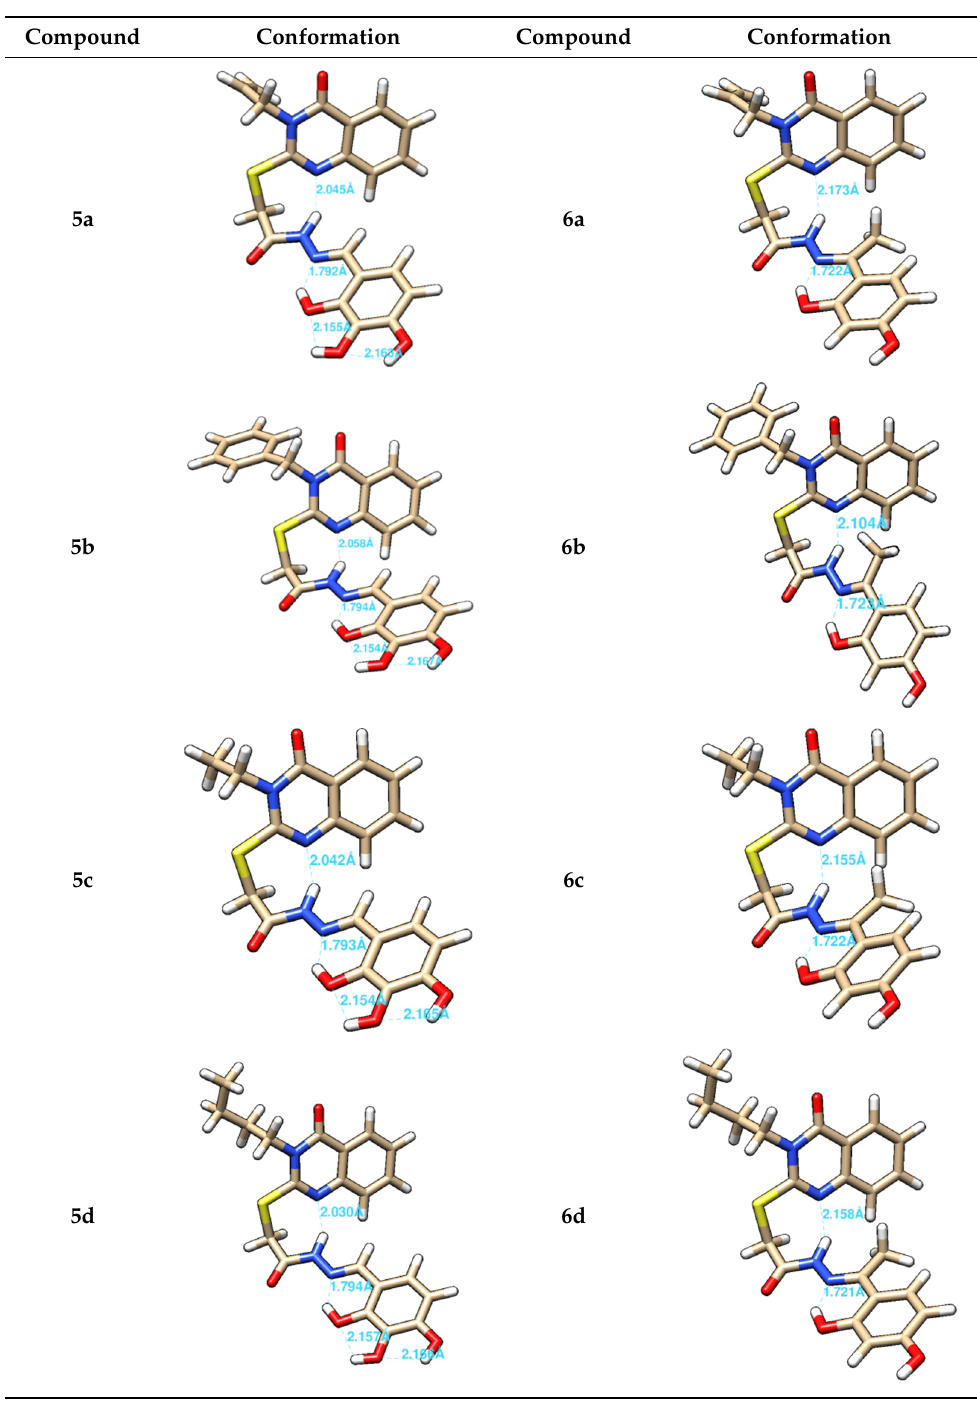
Table 8. The conformation with the lowest energy of the 5a–d and 6a–d compounds with the depiction of the resulting hydrogen bonds.